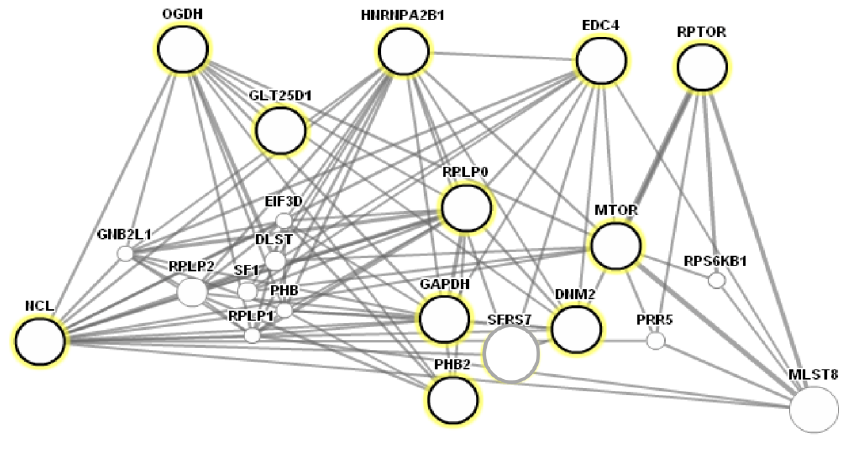
Figure 6. Biological interaction prediction of mTORC1 interacting proteins. An interaction map was predicted by using a web-based interface, GeneMANIA. The highlighted nodes represent mTOR or RPTOR (raptor) interacting